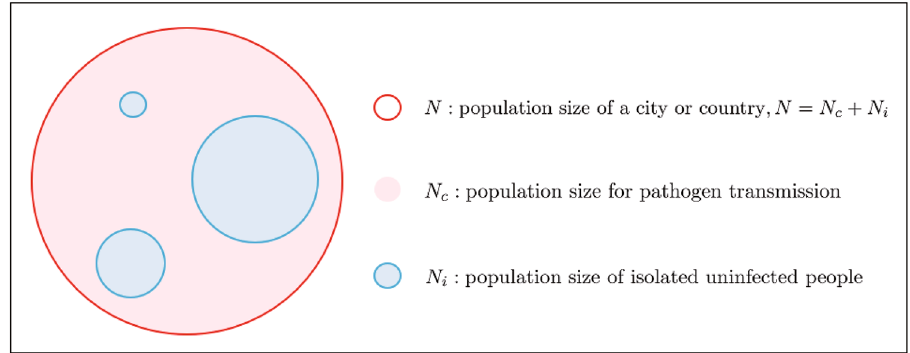
Figure 1. The total population and its